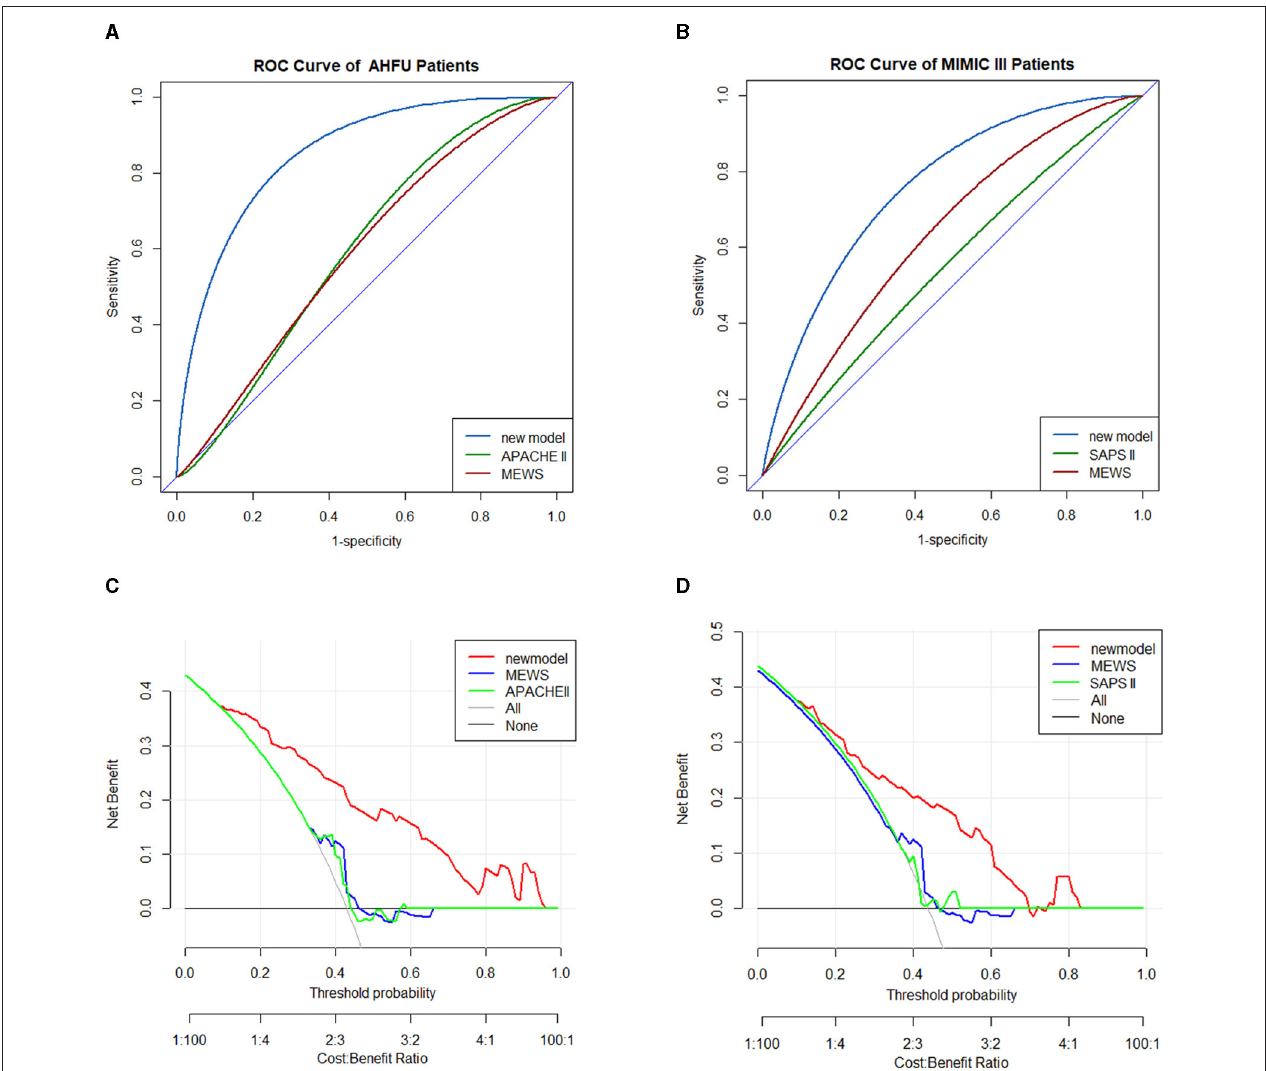
FIGURE 4 | Validation of predicting nomogram model in AHFU and MIMIC III patients. The ROC analyses of in-hospital mortality of the nomogram model and MEWS in the AHFU cohort (A) and MIMIC III cohort (B) . DCA curve for in-hospital mortality in the AHFU cohort (C) and MIMIC III cohort (D) . AHFU, acute heart failure unit; DCA, decision curve analyses; MEWS, Modified Early Warning Score; MIMIC III, medical information mart for intensive care III; ROC, receiver operating characteristic